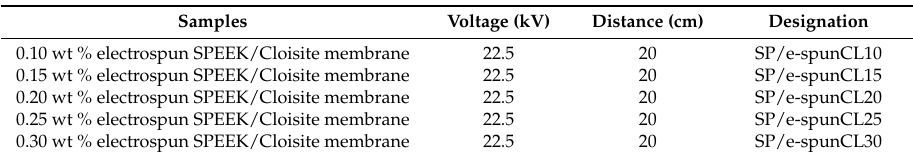
Figure 1. ( a – c ) The preparation steps in producing void free dense SP/e-spun CL membranes. Table 1. The designation of membrane